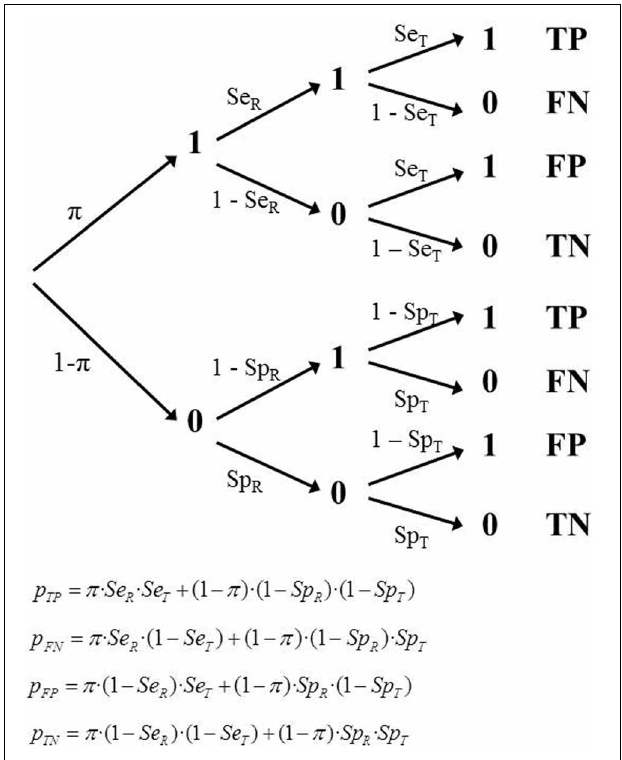
FIGURE 3 | Tree diagram of Model 2 (IR) and the corresponding